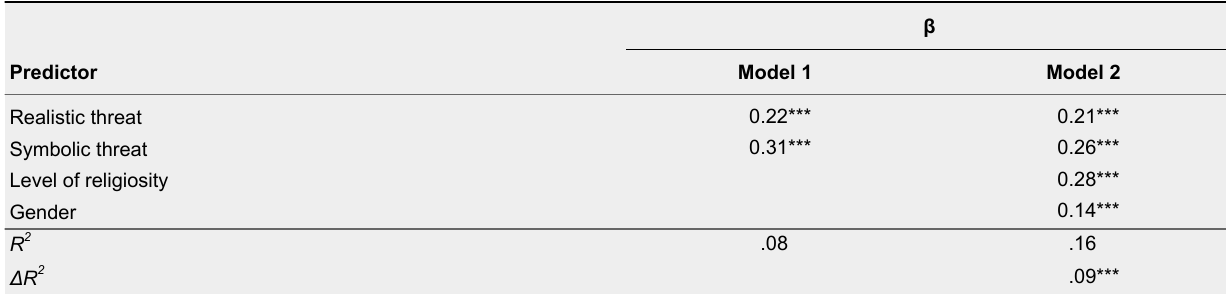
Regression on the Second Factor of Prejudice